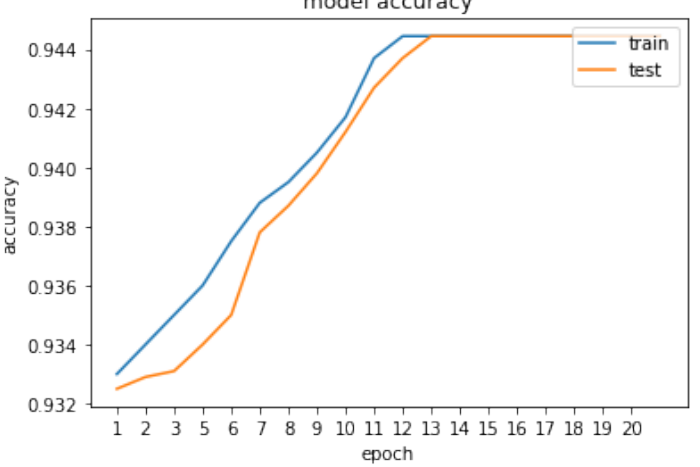
Figure 4. Accuracy of the proposed model during training and testing using MCAD Dataset.